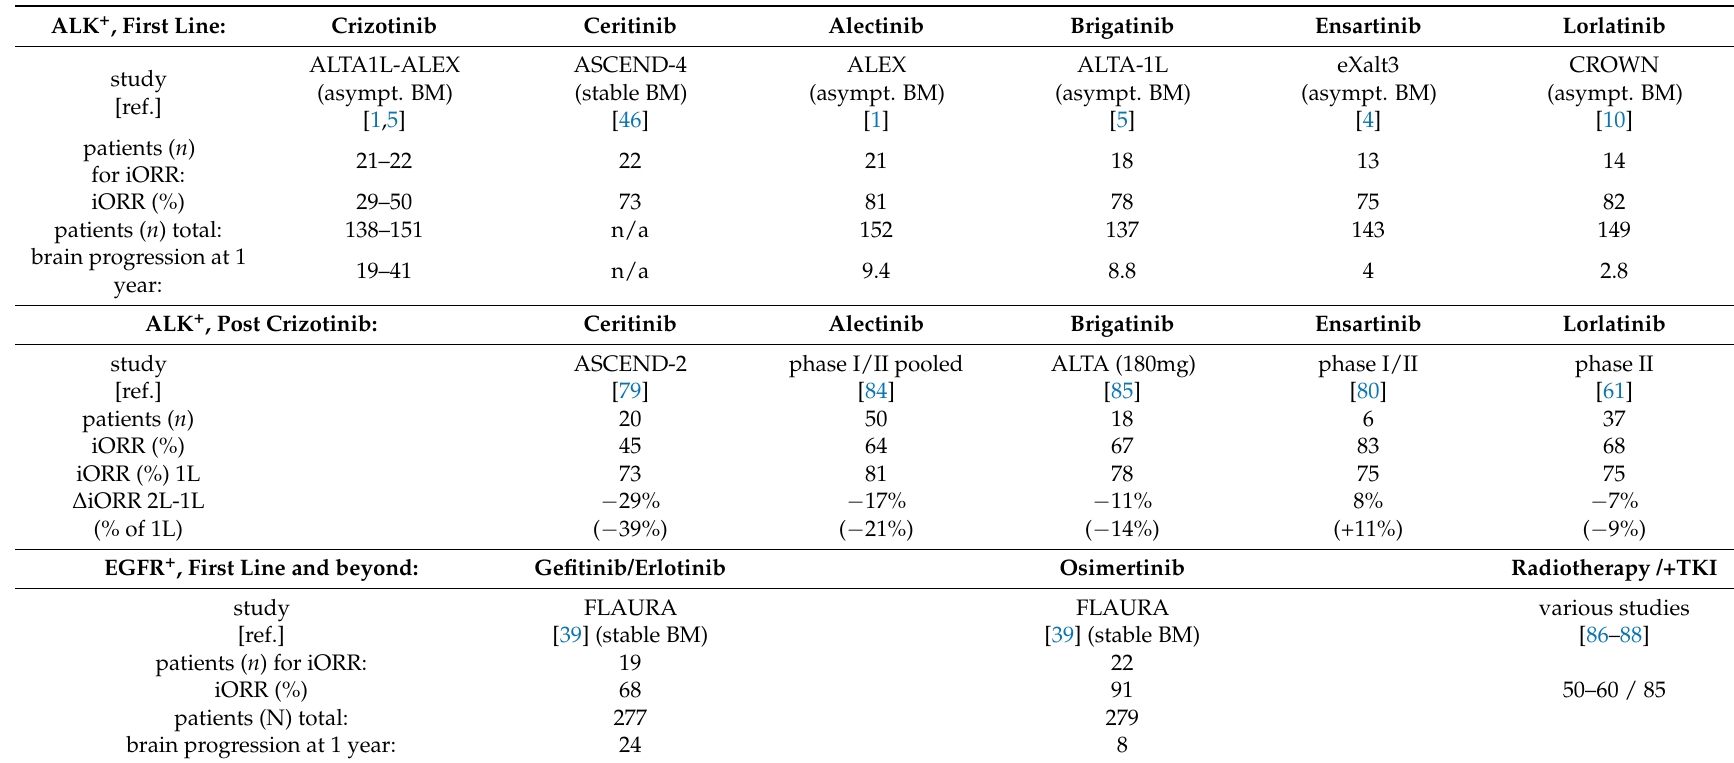
Table 2. Brain efficacy of ALK inhibitors and other options upfront and as next-line